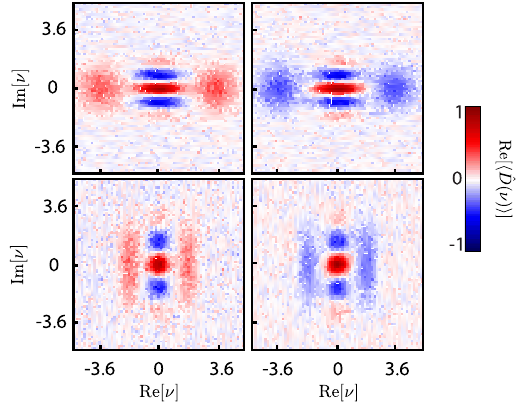
FIG. 3. Characteristic functions of cat and compressed cat states. Real part of the measured characteristic function of even and odd cat states of size j α j ¼ 1 . 8 with 0 dB (top) and approximately − 6 . 7 dB (bottom) compression. The blobs, which correspond to quantum interference, are centered at 2 j α j ≈ 3 . 6 and 2 j α j ≈ 1 . 8 , respectively. They also reflect the photon number parity of the state in the characteristic function representation, and are pushed closer to the origin by compressing the